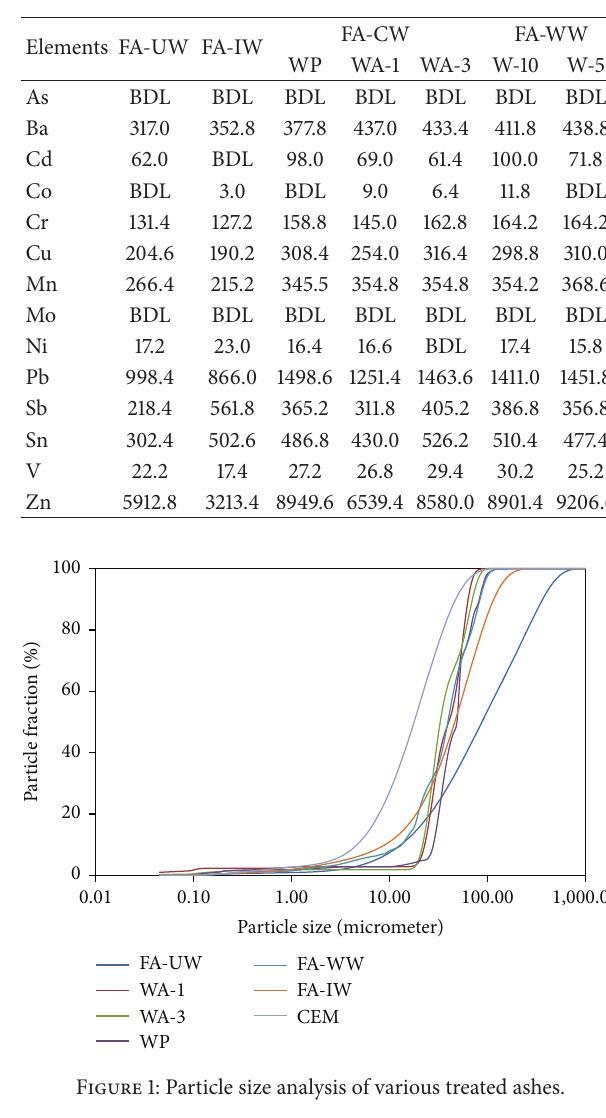
Table 1: Composition of mortars.